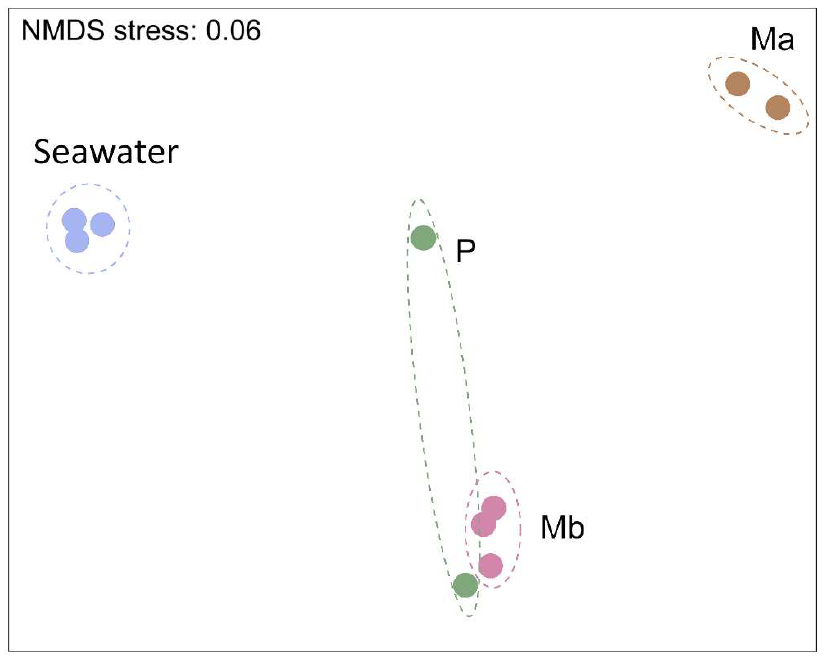
Figure 2. Non-metric multidimensional scaling ordination (NMDS) of Millepora alcicornis (Ma), Mussismilia braziliensis (Mb), Porites astreoides (P), and seawater samples based on Bray–Curtis similarity distances.